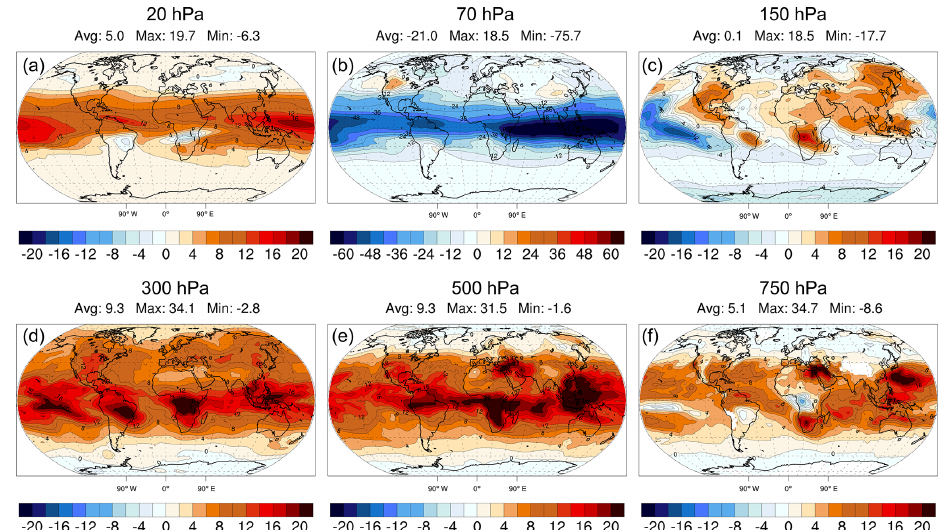
Figure 8. Relative average differences (%) between radiances and Level 2 assimilation (L1a minus L2a divided by the corresponding O 3 values of the control simulation in Fig. 6) for July 2010. Same plots as in Fig.